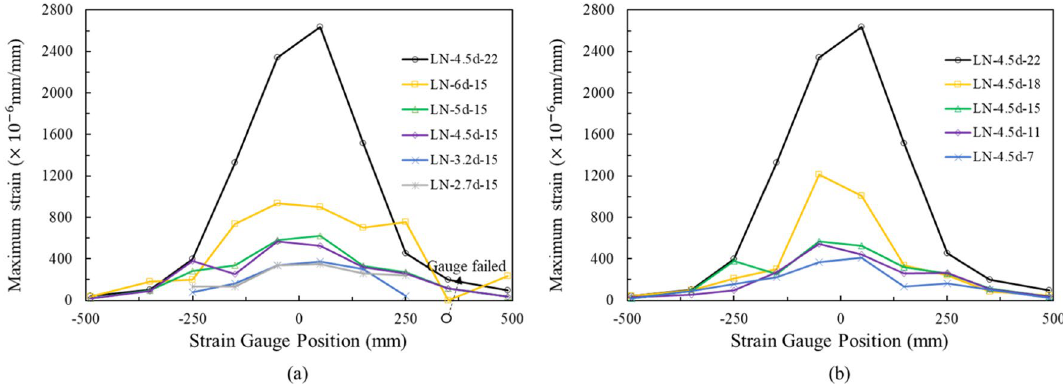
Figure 16. Maximum strain in anchor stirrup reinforcement: ( a ) edge distance, ( b ) embedment depth.